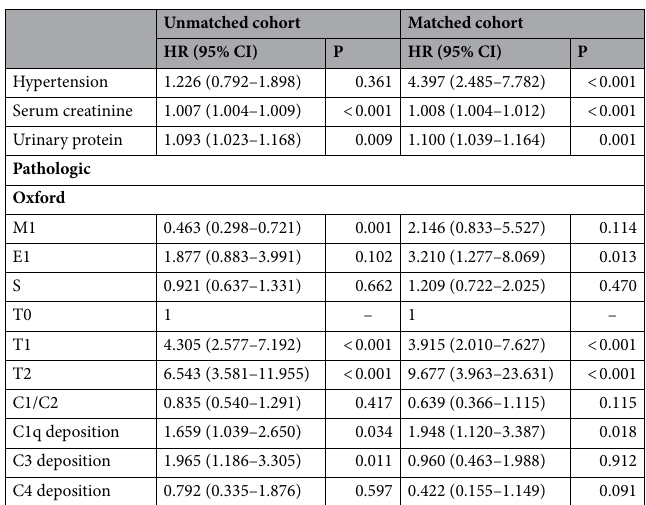
Table 4. Cox proportional hazard model for the primary endpoint in IgA nephropathy patients with CKD. HR hazard ratio, 95% CI 95% confidence interval, M mesangial proliferation, E endocapillary proliferation, S segmental sclerosis, T tubular atrophy/interstitial fibrosis, C